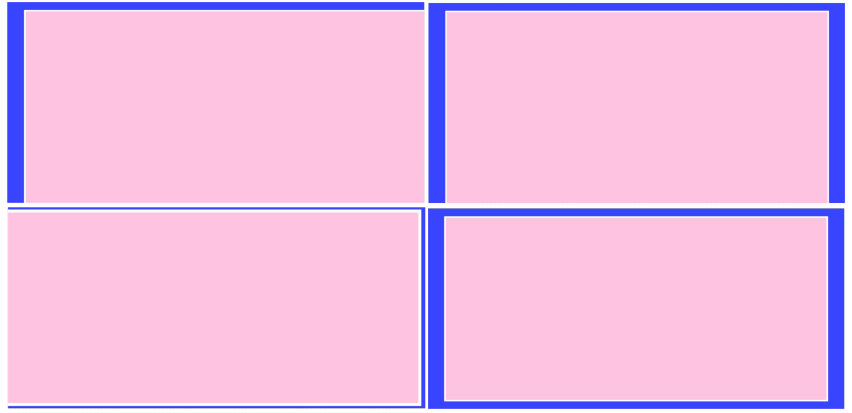
Figure 3. Examples of random bar